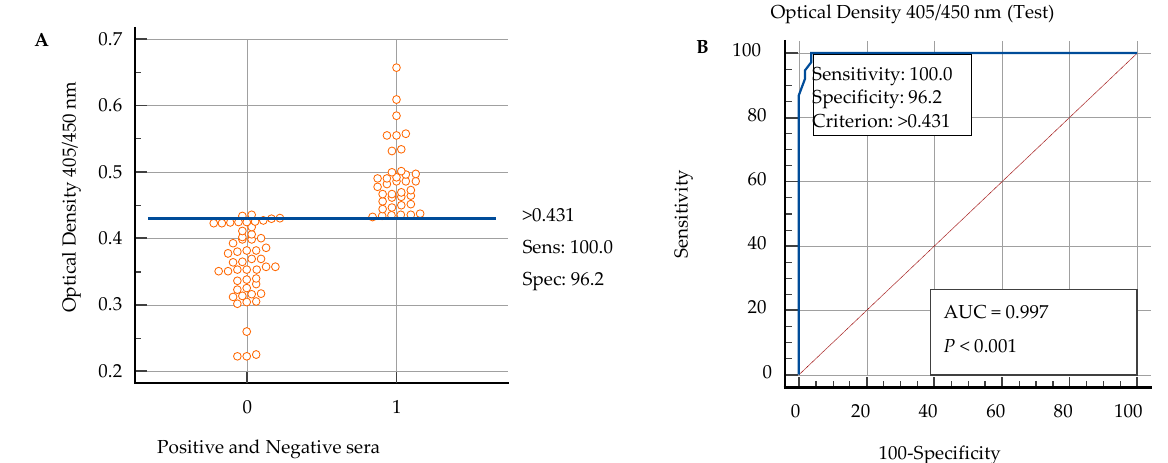
Figure 1. Distribution of toxoplasma-positive and -negative sera detected through Cattle Toxo IgG ELISA kit based on cut-off value (0.431) determined through plotting an ROC curve to find sensitivity and specificity. Sensitivity (Sens), specificity (Spec) ( A ). ROC curve for Cattle Toxo IgG ELISA kit developed through plotting positive versus negative sera identified by Standard ELISA kit to determine the cut-off value of Cattle Toxo IgG ELISA kit ( B ).